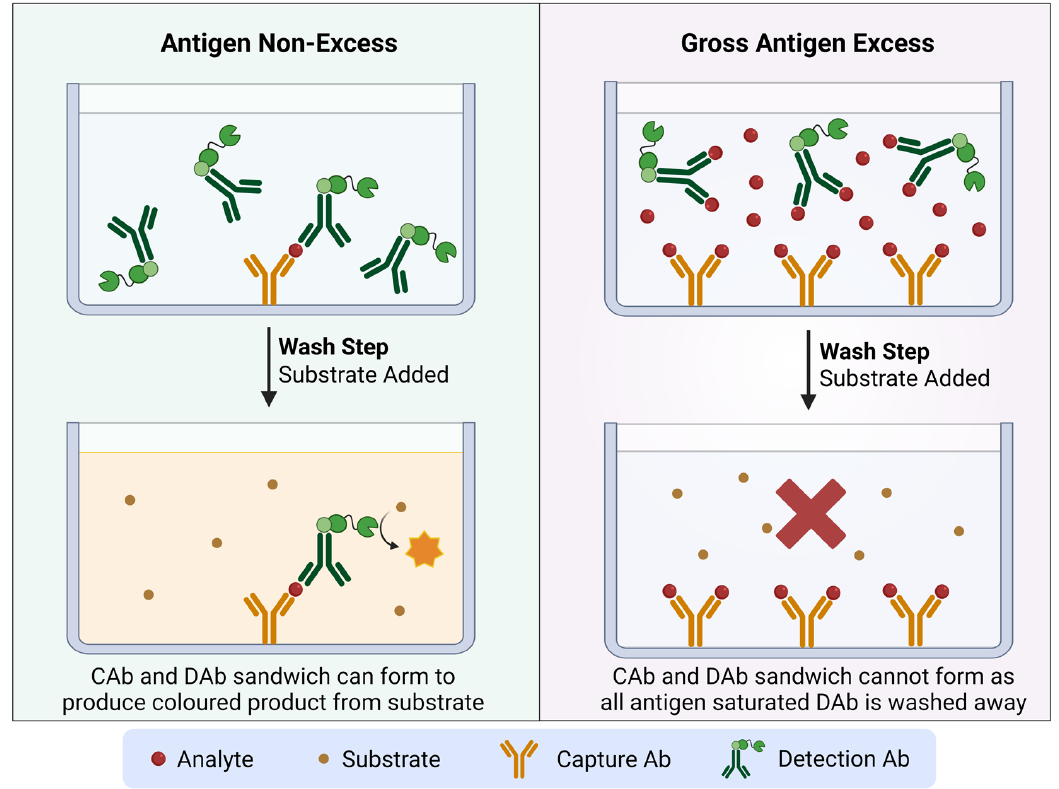
Figure 5. Mechanism of antigen excess interference—also called the hook/prozone effect—in one step sandwich immunoassay systems. Detection of antigen occurs when a sandwich is formed by the binding of the capture antibody (CAb) and the detection antibody (DAb) to the antigen. When antigen is in excess, sandwiches are not formed, as all binding epitopes are saturated by antigen, hence the DAb lost in the wash step. Created with Biorender.com .